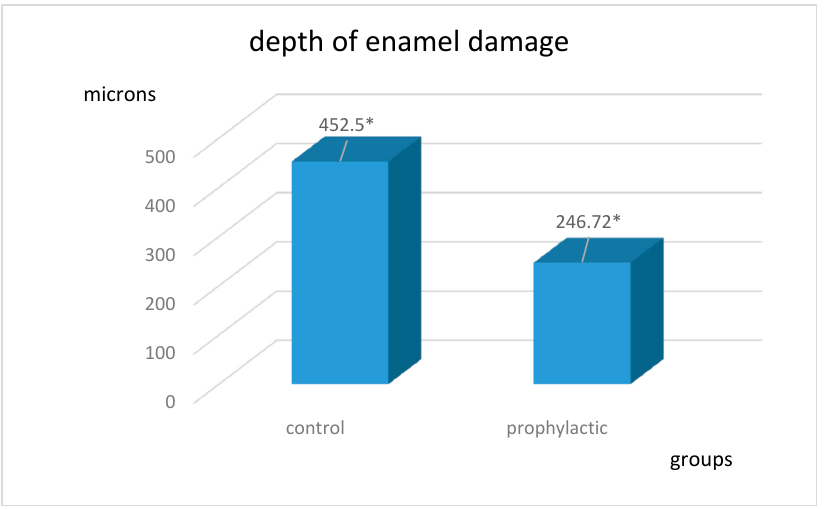
Figure 2. Depth of enamel damage in the control and prophylactic groups in microns. * The results obtained are statistically significant: p < 0.0001.